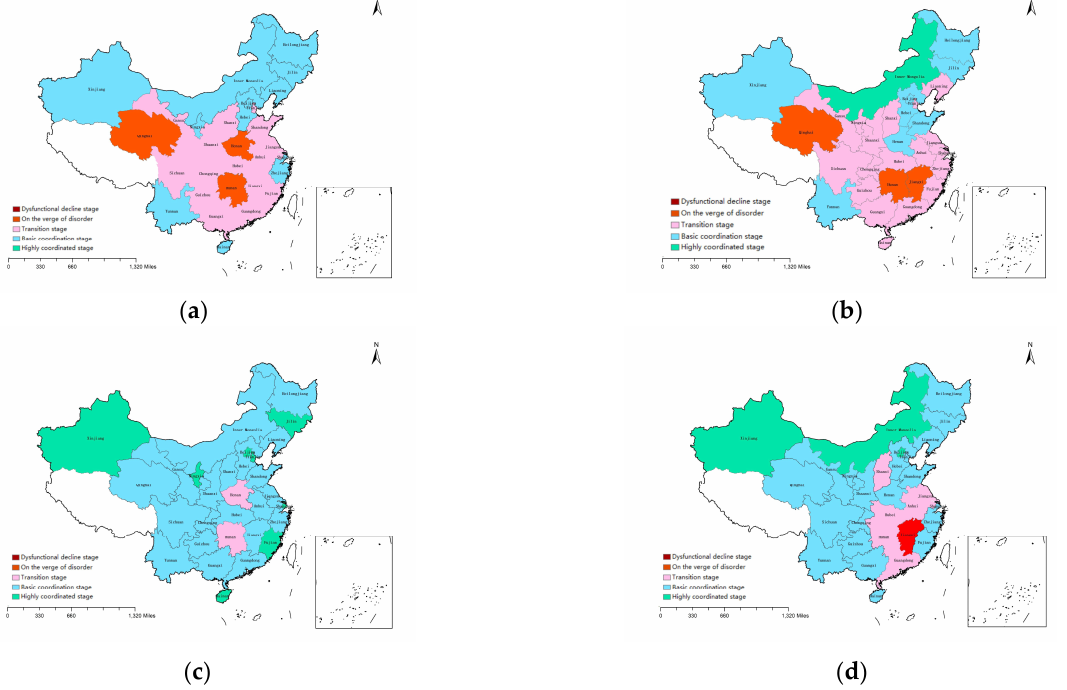
Figure 7. Distribution of coupling coordination degree between agricultural carbon emissions and agricultural modernization. Note: ( a ) Total coupling coordination (D1) in 2010. ( b ) Intensity of coupling coordination (D2) in 2010. ( c ) Total coupling coordination (D1) in 2020. ( d ) Intensity of coupling coordination (D2) in 2020.